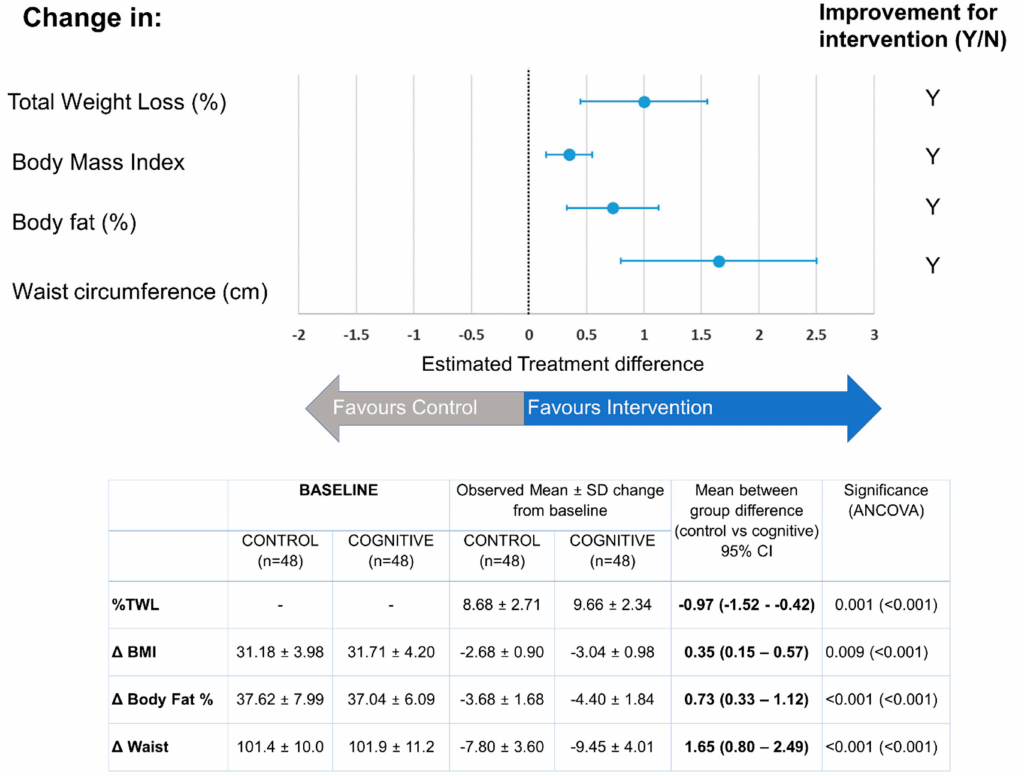
Figure 2. Three-month change estimates for anthropometric variables by treatment. Mean ± SD. Between-group di ff erences were estimated as Mean Cognitive—Mean Control value. A 95% confidence interval of between-group di ff erences is shown in parentheses. Significance was analysed by an ANCOVA test. Significance data, controlling for baseline anthropometric values and sex, is shown in parentheses. Statistical significant di ff erences that are favourable to the cognitive group have been denoted in bold.